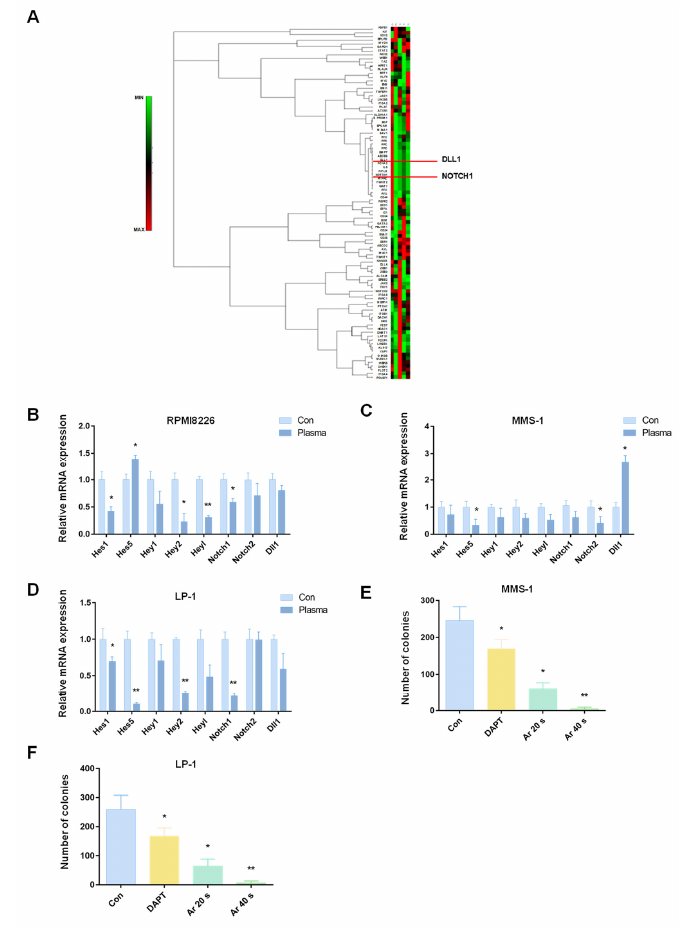
Figure 4. Plasma suppressed MM cell colony formation by inhibiting the Notch